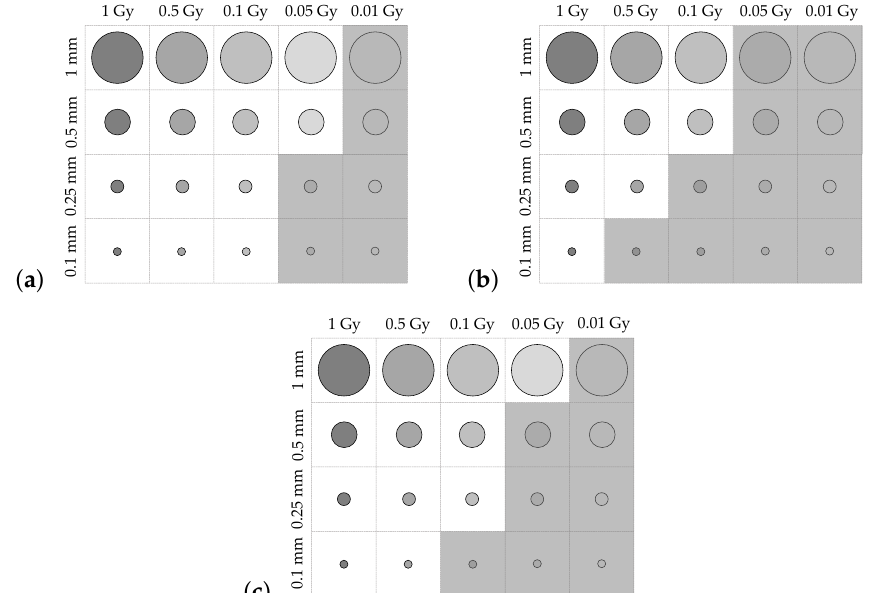
Figure 12. Comparison of contrast-detail plots for the dosimeter with: ( a ) No uncertainties; ( b ) simulated atmospheric turbulence; ( c ) simulated mechanical vibrations. Greyed-out regions indicate voxels that could not be